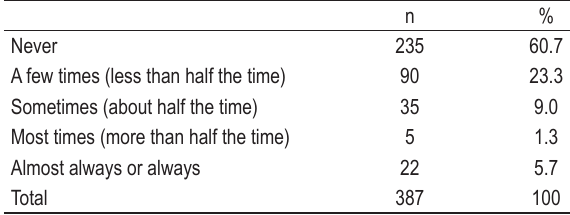
TABLE 10. Pain sensation after sexual activity